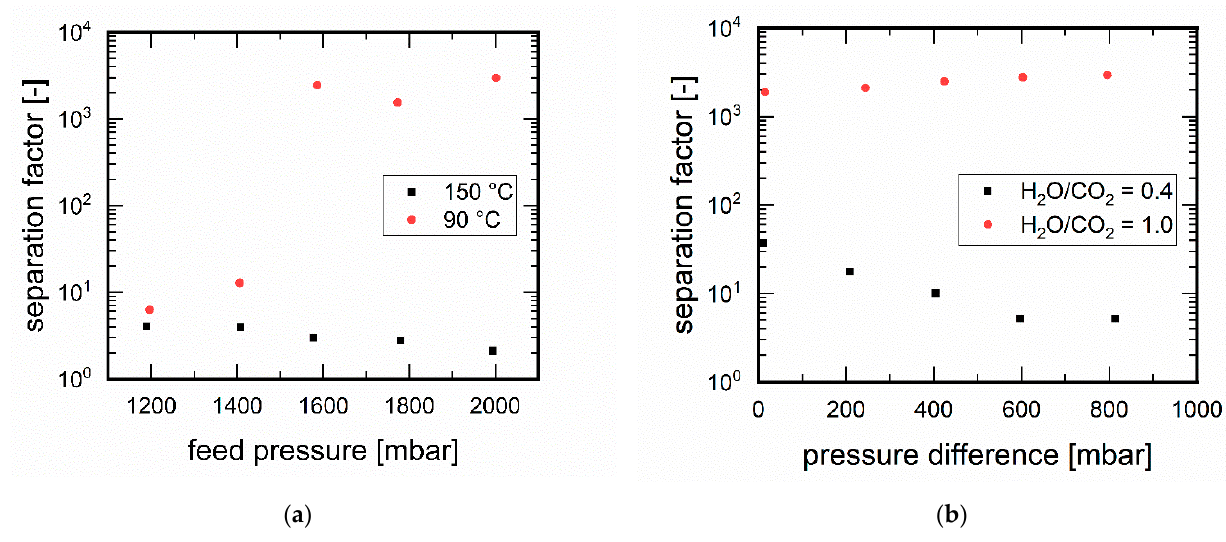
Figure 7. Dependence of pressure: ( a ) feed pressure-dependent separation factors at temperatures of 150 and 90 °C, at feed pressures of 1.0 to 2.0 bar; permeate pressure 1.0 bar, H 2 O/CO 2 ratio = 1.0; ( b ) permeate pressure-dependent separation factors for the H 2 O/CO 2 ratios of 0.4 and 1.0, retentate pressure at 1.8 bar.